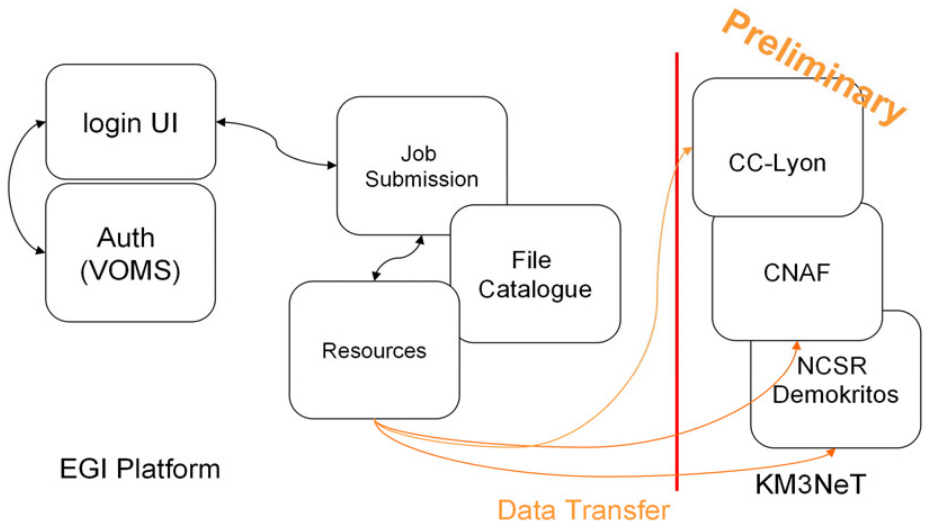
Figure 2. KM3NeT-EGI flowchart, first